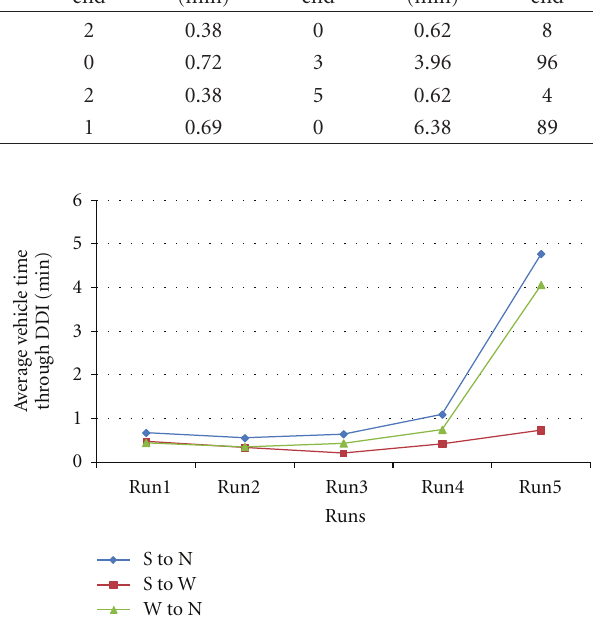
Figure 5: Average times through